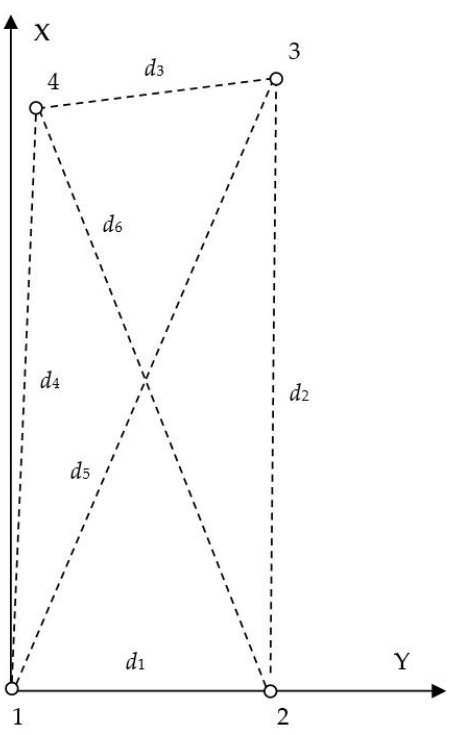
Figure 2. A pseudo-distance scheme between controlled points. Table 2. Theoretical distances d t